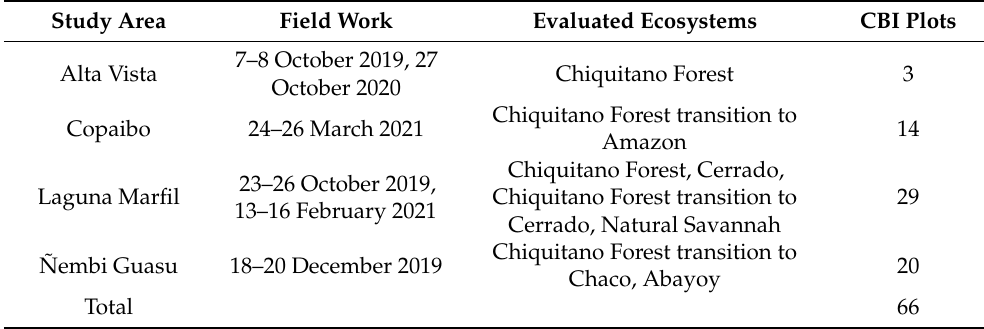
Table 4. Distribution of CBI plots for the evaluation of fire severity in the field in the four study areas in the Department of Santa Cruz.